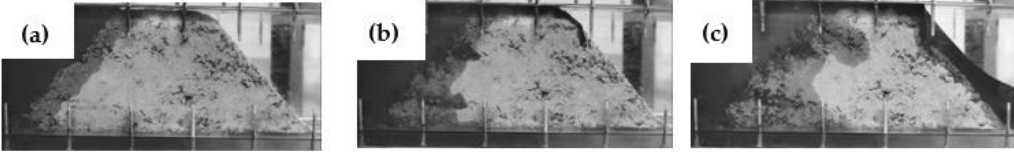
Figure 17. Failure mechanism of a barricade made of the GSD #2: ( a ) after the filling, ( b ) during the increase of the pressure using the hand piston, and ( c ) at failure (at the end of the test).